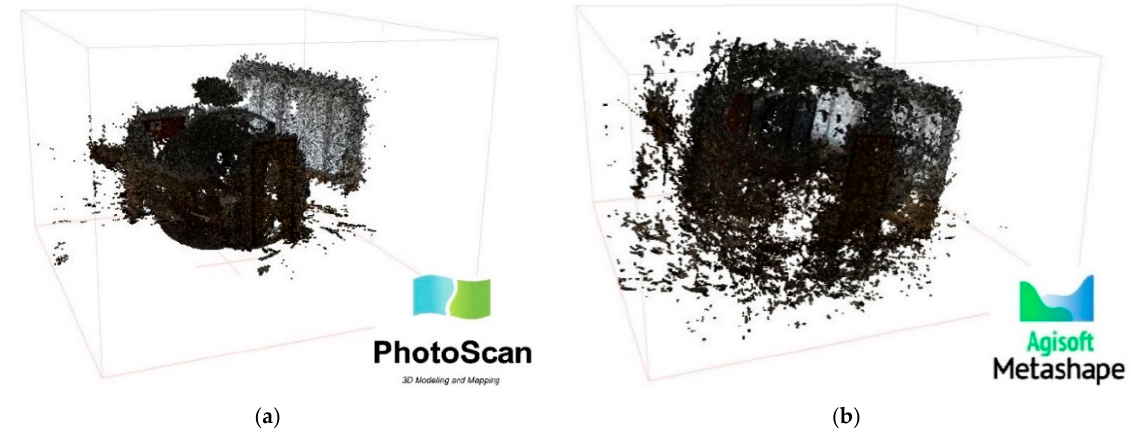
Figure 3. Results of point cloud (room of the laboratory) processing in Agisoft Photoscan ( a ) and Agisoft Metashape ( b ).